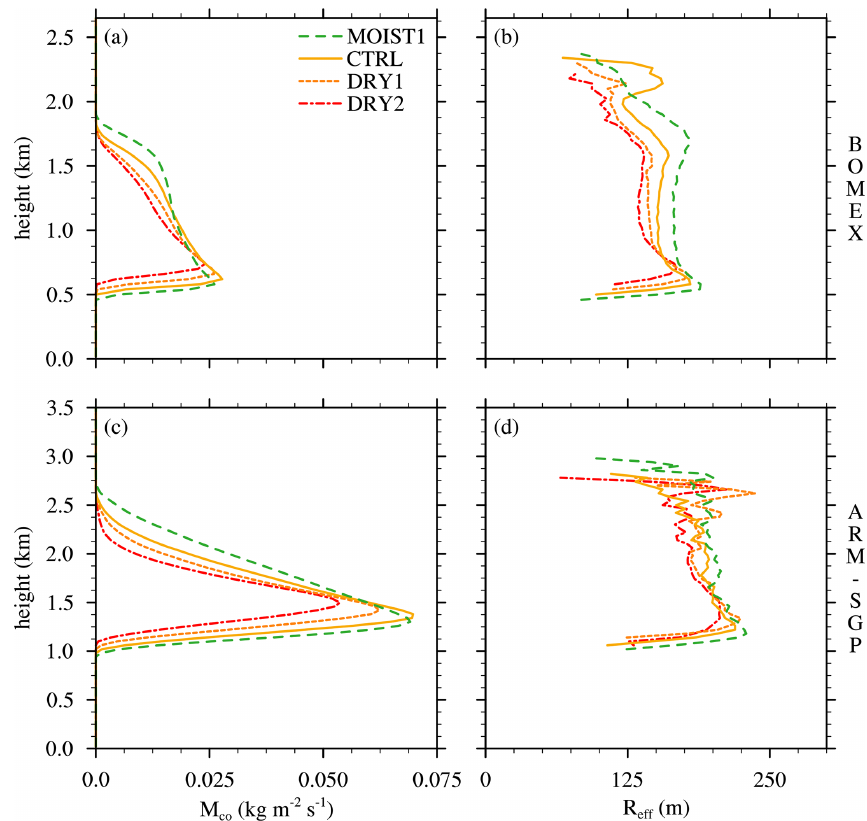
Figure 4. Conditionally averaged cloud-core mass flux ( M co ) and effective cloud radius ( R eff ) for the cloud-layer RH experiments for (a– b) BOMEX and (c–d) ARM-SGP,